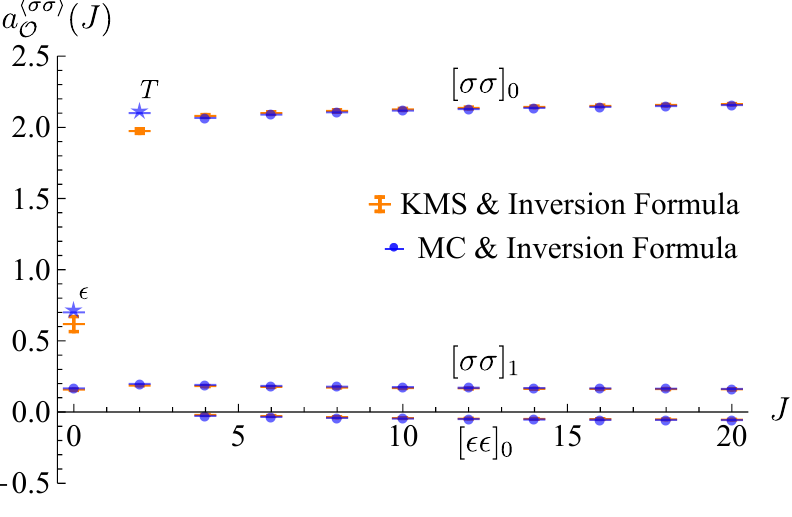
Figure 4. Thermal coe(cid:14)cients for the three families [ (cid:27)(cid:27) ] 0 , [ (cid:27)(cid:27) ] 1 , and [ (cid:15)(cid:15) ] 0 . The orange horizontal lines are obtained by using the KMS condition in combination with the thermal inversion formula and by averaging over several parameter choices. The spread given by the orange error bars is obtained by computing the operator mixing using di(cid:11)erent sets of z values as explained in section 4.4 and by imposing the KMS conditions in di(cid:11)erent regions on the thermal cylinder (see (cid:12)gure 13 for an example). The blue stars are MC estimates for a h (cid:27)(cid:27) i ; MC (cid:15) = 0 : 711(3) [40] and a h (cid:27)(cid:27) i ; MC 2 : 092(13) [41{43]. The blue lines are the estimates for the thermal coe(cid:14)cients of all other operators in [ (cid:27)(cid:27) ] 0 , [ (cid:27)(cid:27) ] 1 and [ (cid:15)(cid:15) ] 0 families using these MC results together with the inversion formula. Note that the spread of the thermal coe(cid:14)cients of higher-spin operators estimated by the bootstrap are too small to be visible on this